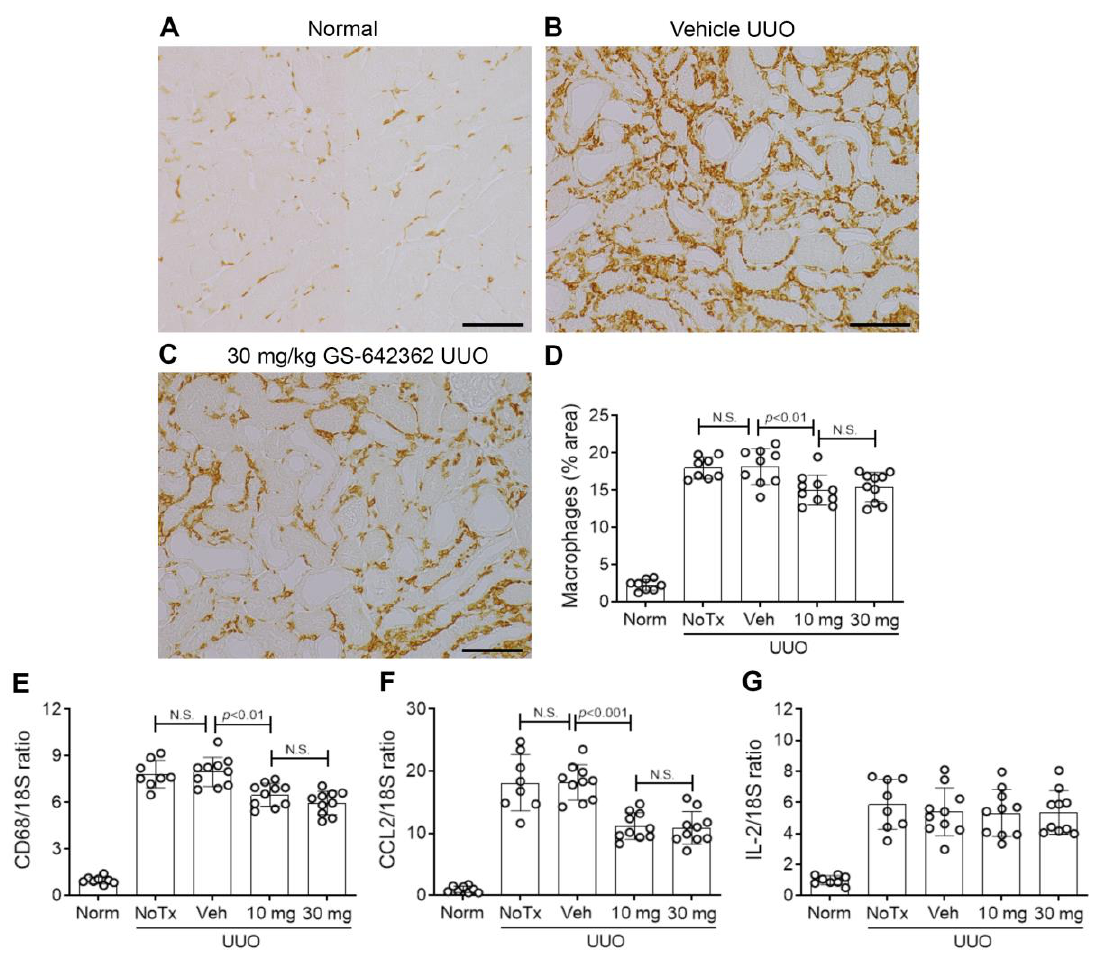
Figure 7. Macrophage infiltration in the day 7 unilateral ureteric obstruction (UUO) model (n = 8 to 10/group). ( A – D ) Immunostaining for F4/80+ macrophages. ( A ) Normal mouse kidney showing resident F4/80+ macrophages. ( B ) Vehicle- treated UUO showing a significant increase in macrophages in the cortex. ( C ) UUO treated with 30 mg/kg GS-642362 shows a partial in macrophage infiltration. Bar = 100 µm. ( D ) Graph of the area of F4/80 macrophage staining. RT-PCR for mRNA levels of ( E ) CD68, ( F ) CCL2, and ( G ) IL-2. N.S., not significant.